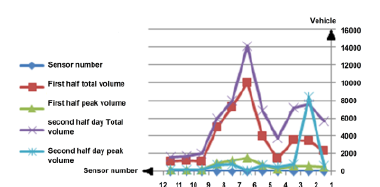
Figure. 5 Showing general changes in the number of passenger cars from (one hour) field study at 7:00 in the morning, June 2, 2012